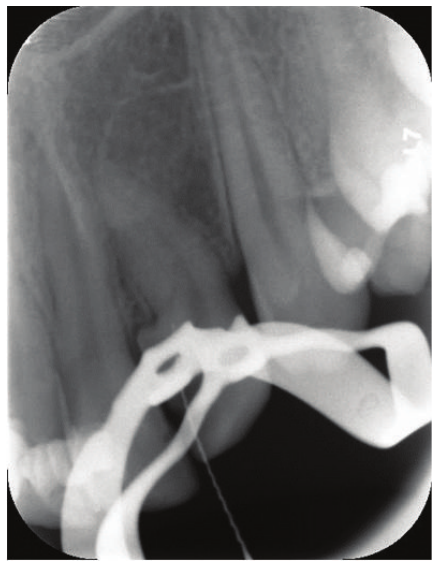
Figure 2: Radiograph showing the fusion of the main canal and invagination.